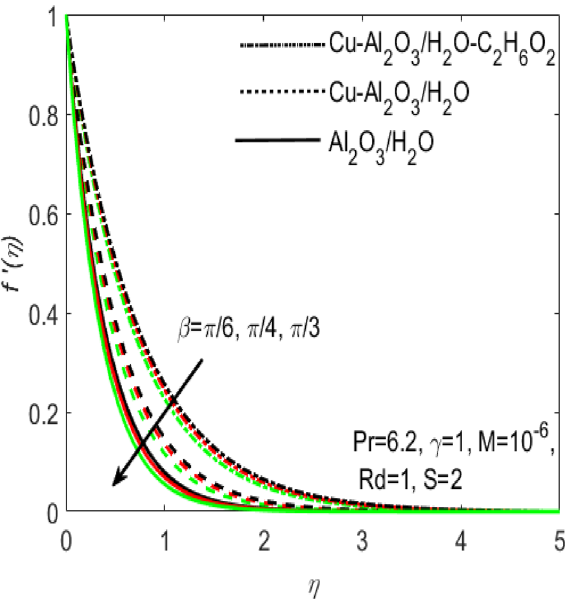
Figure 5. Influence of β on f ′ (η) for different hybrid nanofluids and simple